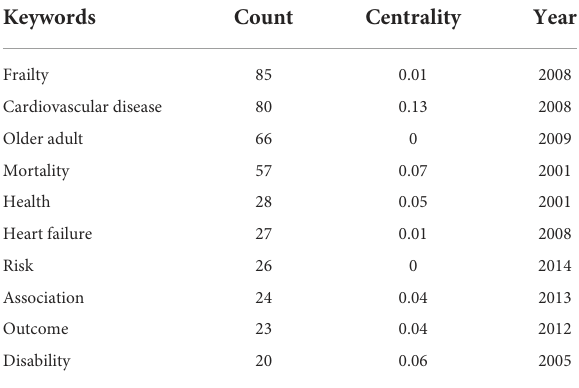
TABLE 3 Top high frequency keywords related to CVD with